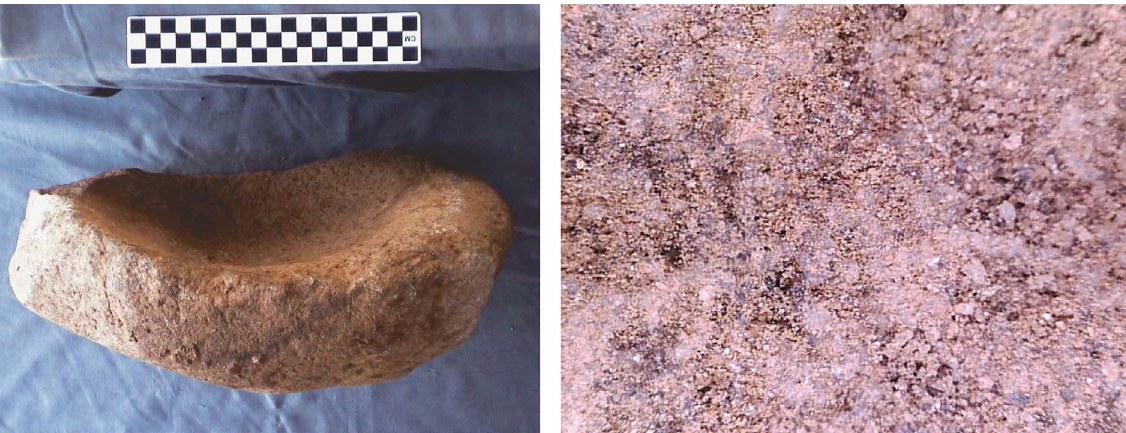
Figure 15. Saddle quern from Khirbat en-Nahas; sandstone rock. Photomicrograph (right) of centre of use surface shows pits and loose rock grains. Image width = 2